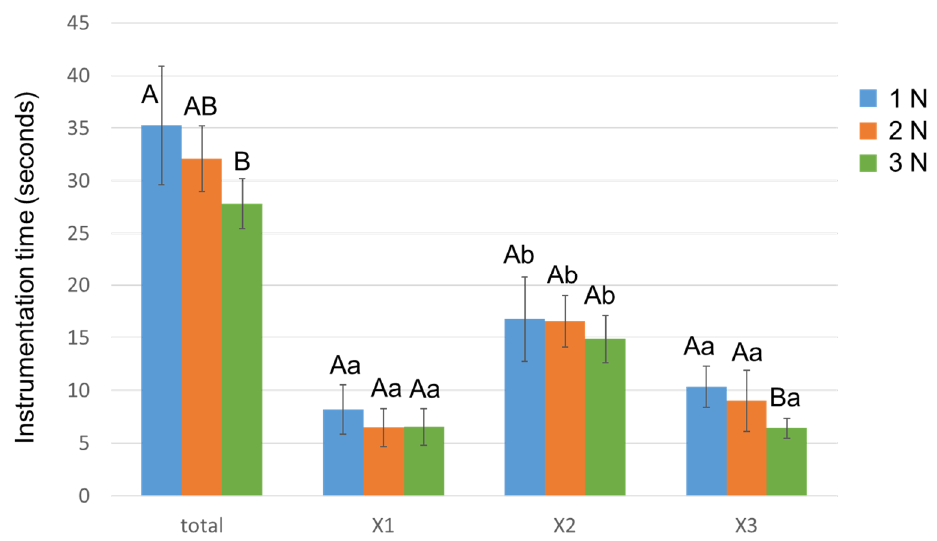
Figure 5. Time required for root canal instrumentation with different downward loads. The instrumentation time was measured for PTN X1, X2, and X3 instruments. Data are the mean and standard deviation ( n = 10 in each group for each instrument). Values with different capital letters in the same instrument and values with different small letters at the same downward load are significantly different ( p < 0.05).